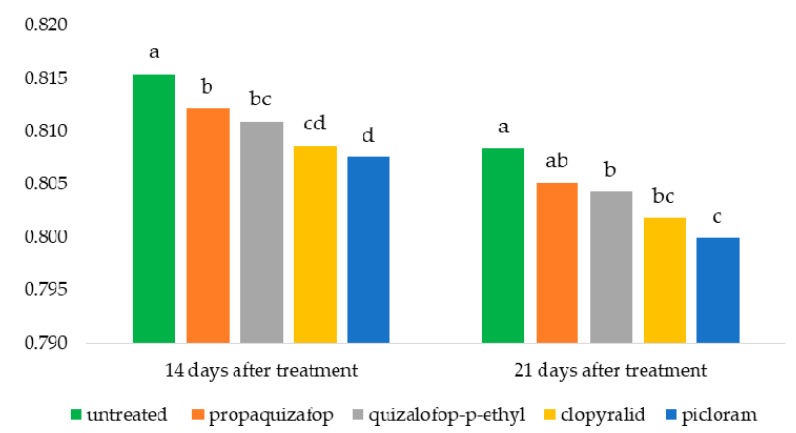
Figure 4. The e ff ect of herbicides on Fv / Fm—maximum Photochemical E ffi ciency of Photosystem II